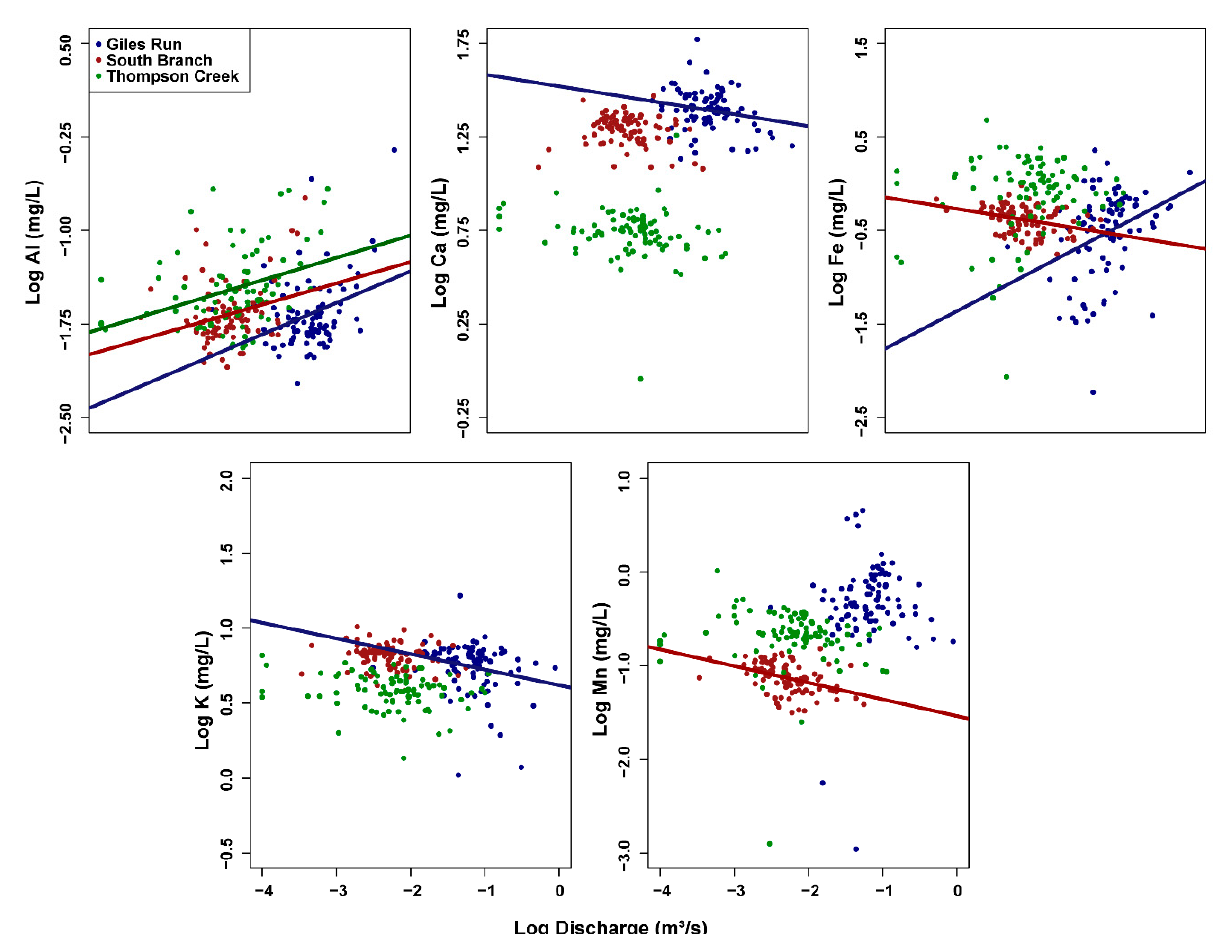
Figure 4. Log [concentration]—log [discharge] plots of selected surface water variables for Giles Run (blue), South Branch (red), and Thompson Creek (green). Plots are only shown when at least one stream had a C–Q relationship with a slope significantly different from 0. Regression lines of best fit included when the relationship was significant at p < 0.05. See Figure S1 for C–Q plots of all variables.